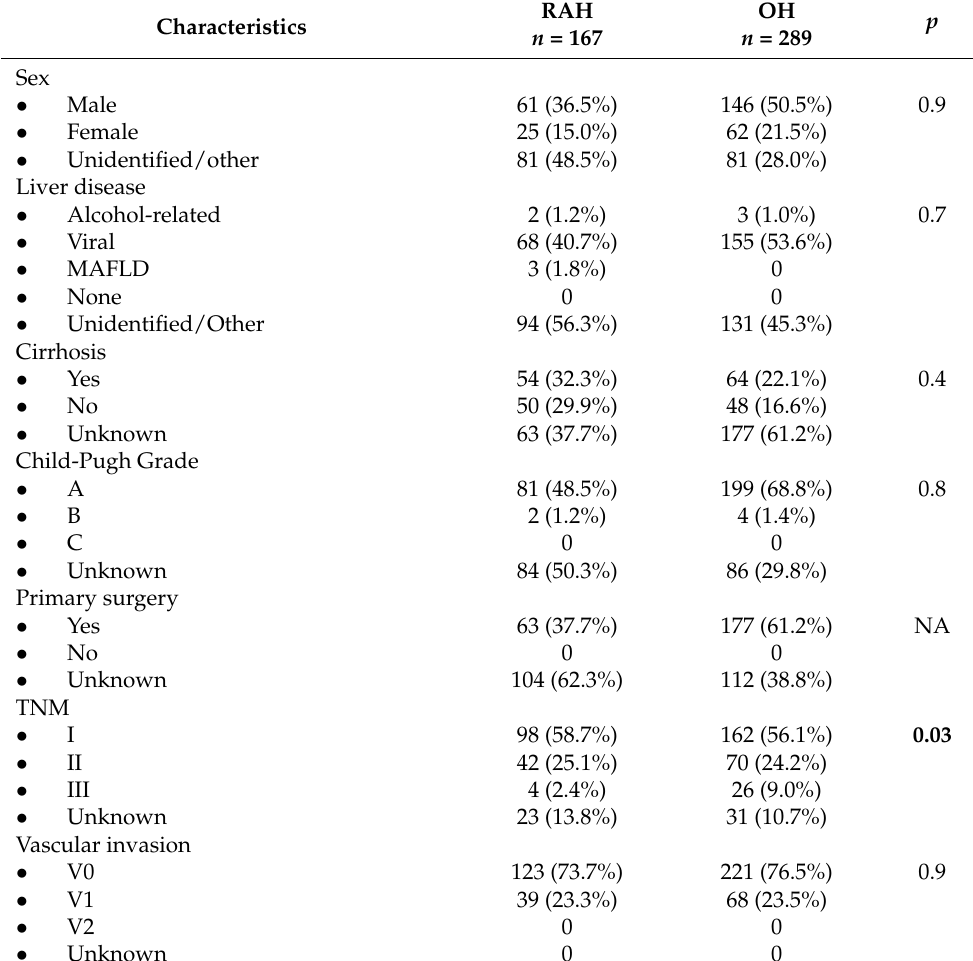
Table 4. Aggregated demographics for RAH versus OH